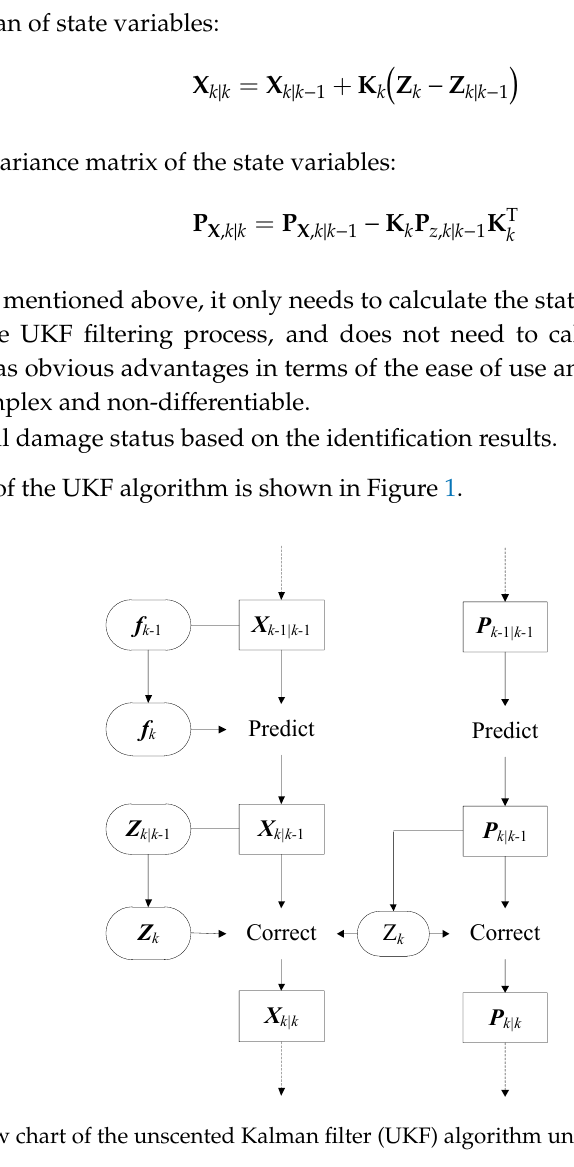
Figure 1. Flow chart of the unscented Kalman filter (UKF) algorithm under known